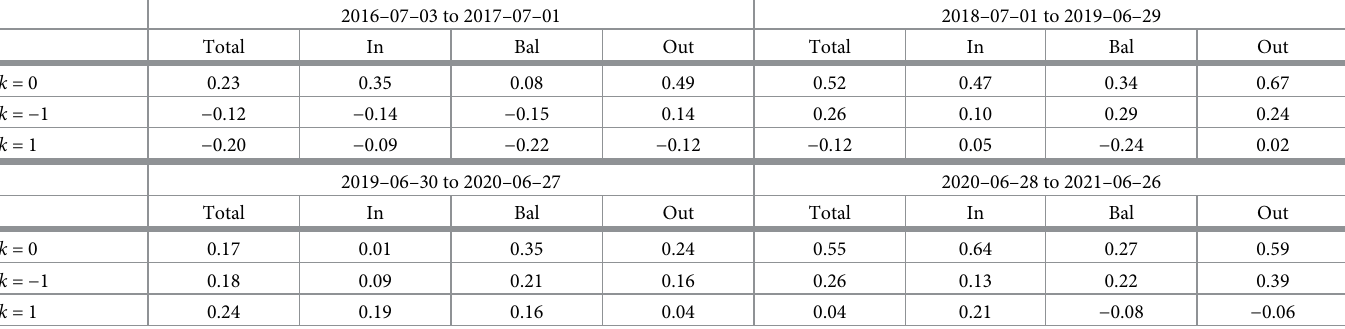
Table 7. Correlation between the time difference of price, Δ p ( t ), and the time difference of the number of Total, In, Bal, and Out active players, Δ N i ( t ) for each target period. k represents the lag time. For example, k = 1 means the correlation between Δ p ( t − 1) and Δ N i ( t